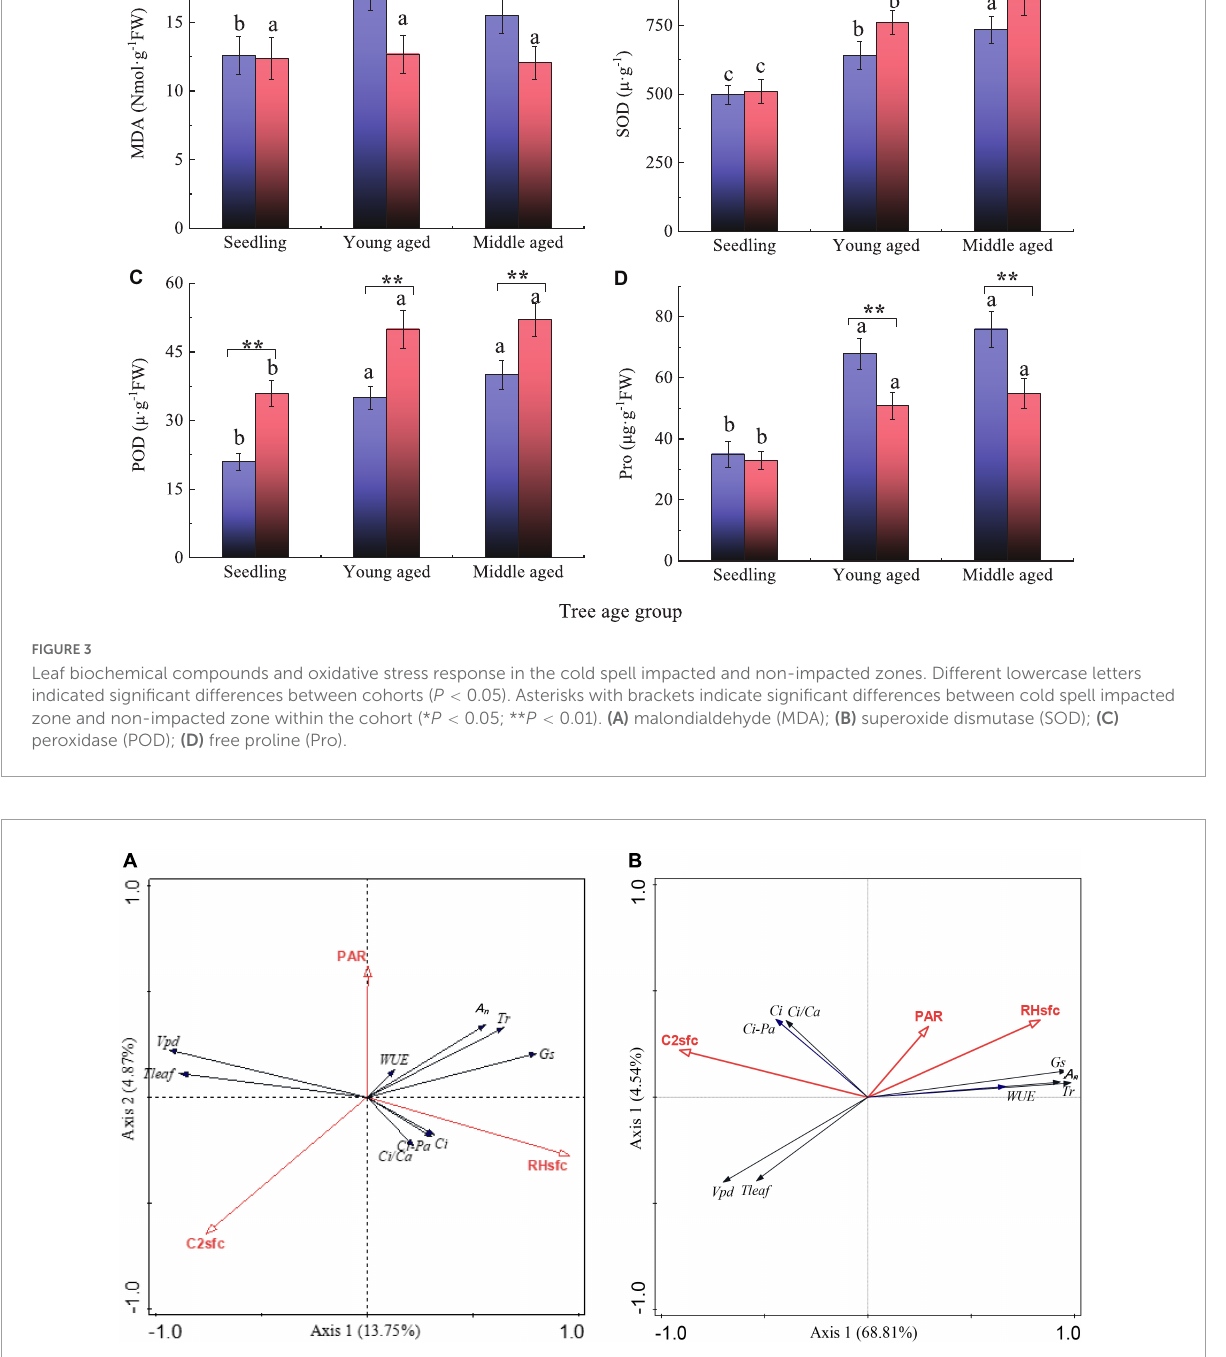
Frontiers in Ecology and